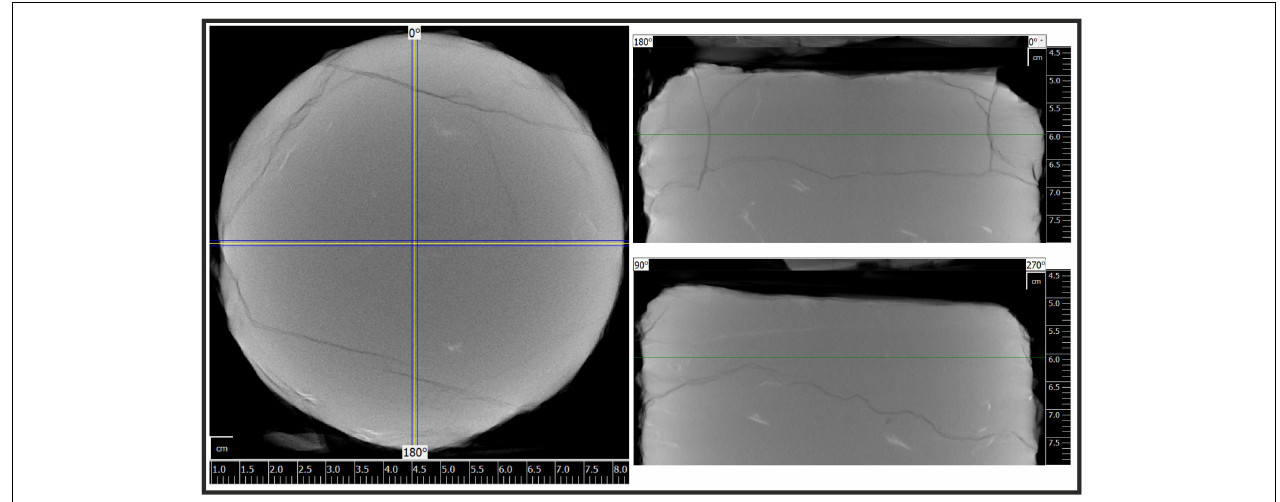
FIGURE 6 | CT scans of the palaeosol from Melbourne 1 shown in Figure 5 at 986.90 m – 986.94 m generated using the RXCT. Left, Cross section showing incipient fractures in the core. Bottom Right, Orthogonal view (90 – 270 ◦ ) of the core, Green line corresponds to the cross section shown in Top image. Top Right, Orthogonal view (0 –180 ◦ ) of the core, Green line corresponds to the cross section shown in Top